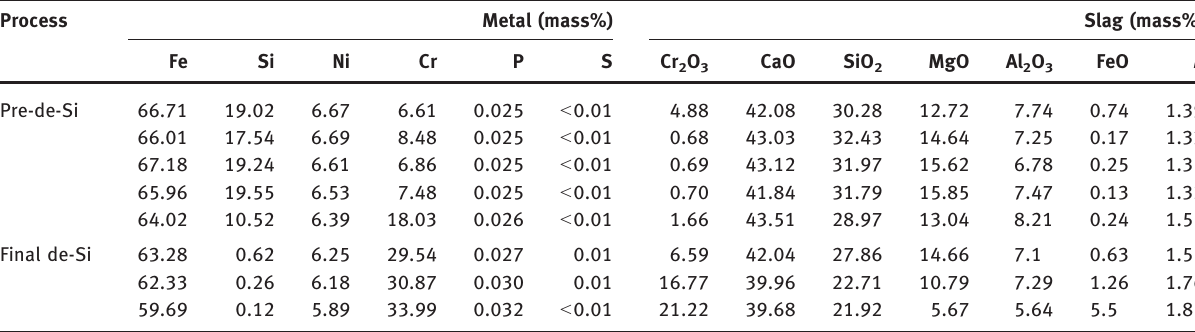
Table 4: Compositions of metal and slag in the de-Si experiments of Ni – Si ferroalloy. Process